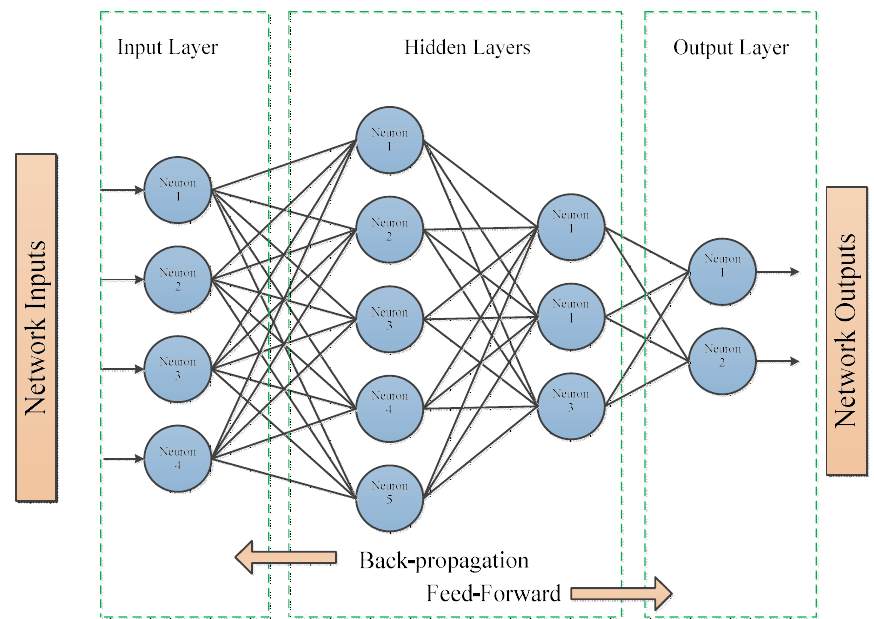
Figure 3. Artificial neural network architectures with feed-forward and backpropagation algorithms.